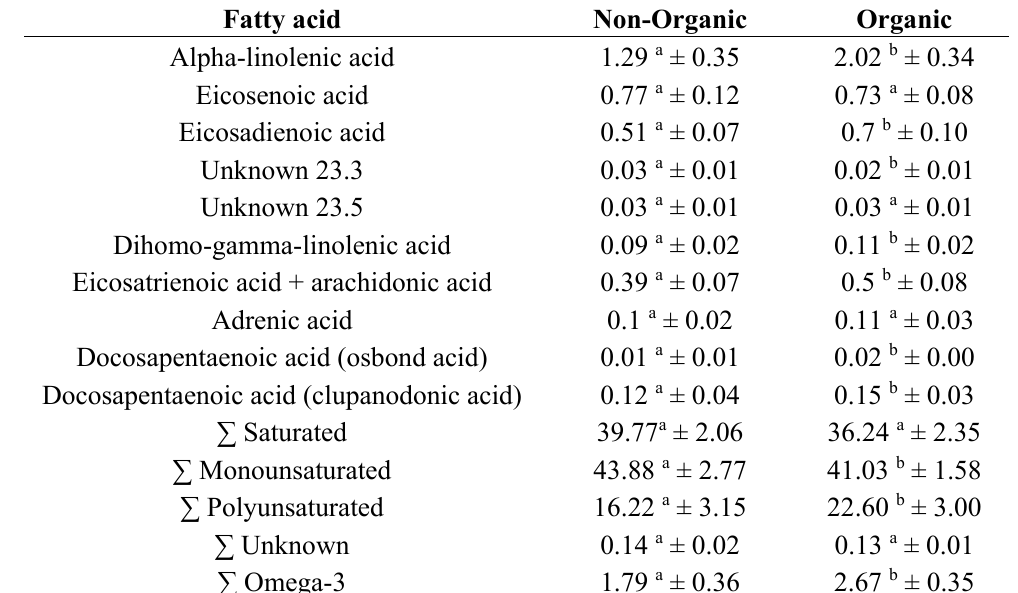
Table 4. Cont. Fatty acid Non-Organic